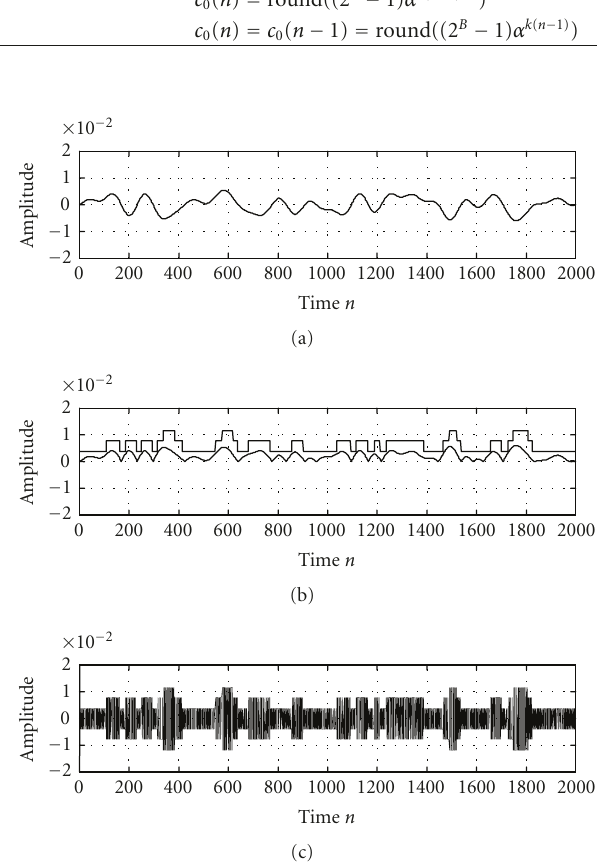
Figure 4: Waveforms as shown in Figure 3, but input signal x ( n ) attenuated by 40